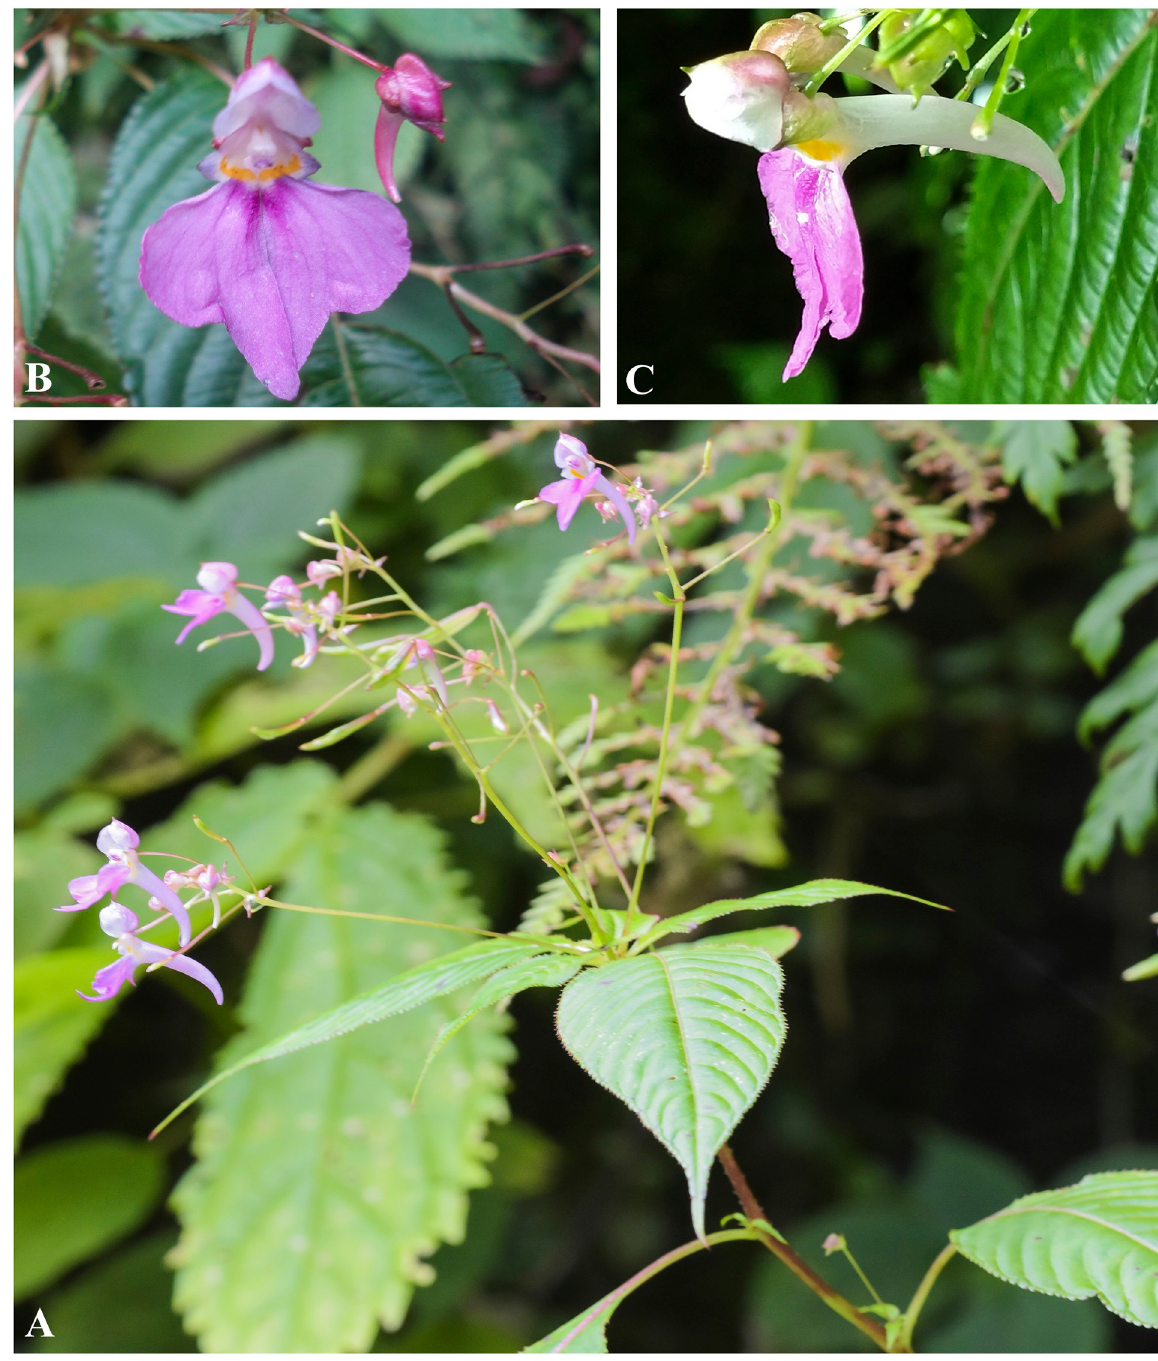
Fig 24. Impatiens scullyi A. Flowering plant; B. Flower (Front view); C. Flower (side view). Photographs by Bhakta Bahadur Raskoti.